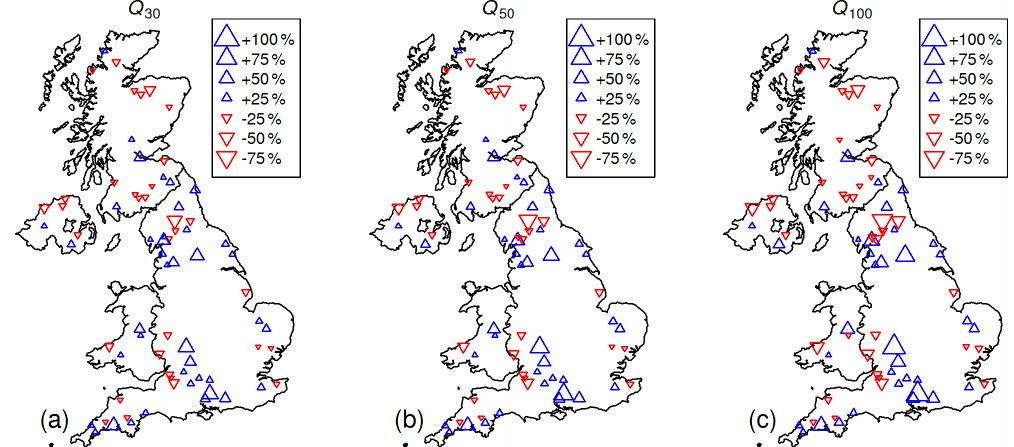
Figure 4. Spatial distribution of trends in the 30-, 50- and 100-year return period floods across the UK Benchmark Network, comparing estimates (percentage increase) from the whole record to estimates just using the first 20 years of record at each